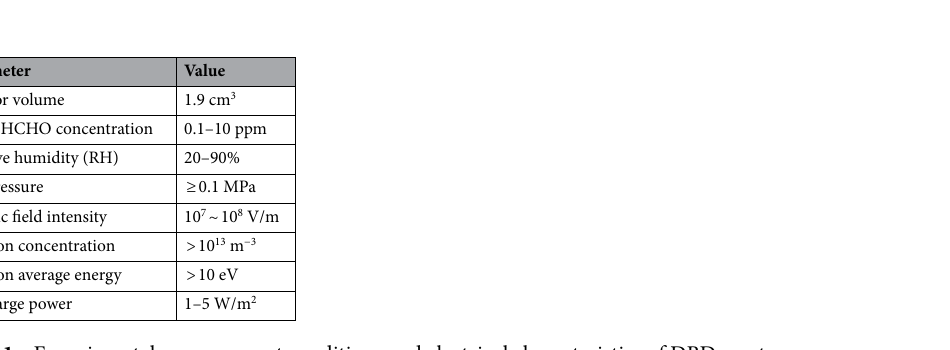
Table 1. Experimental measurement conditions and electrical characteristics of DBD